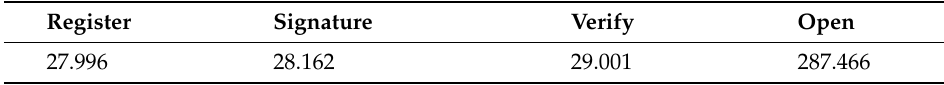
Table 3. Execution Time of Four Stages of Group Signature (ms).